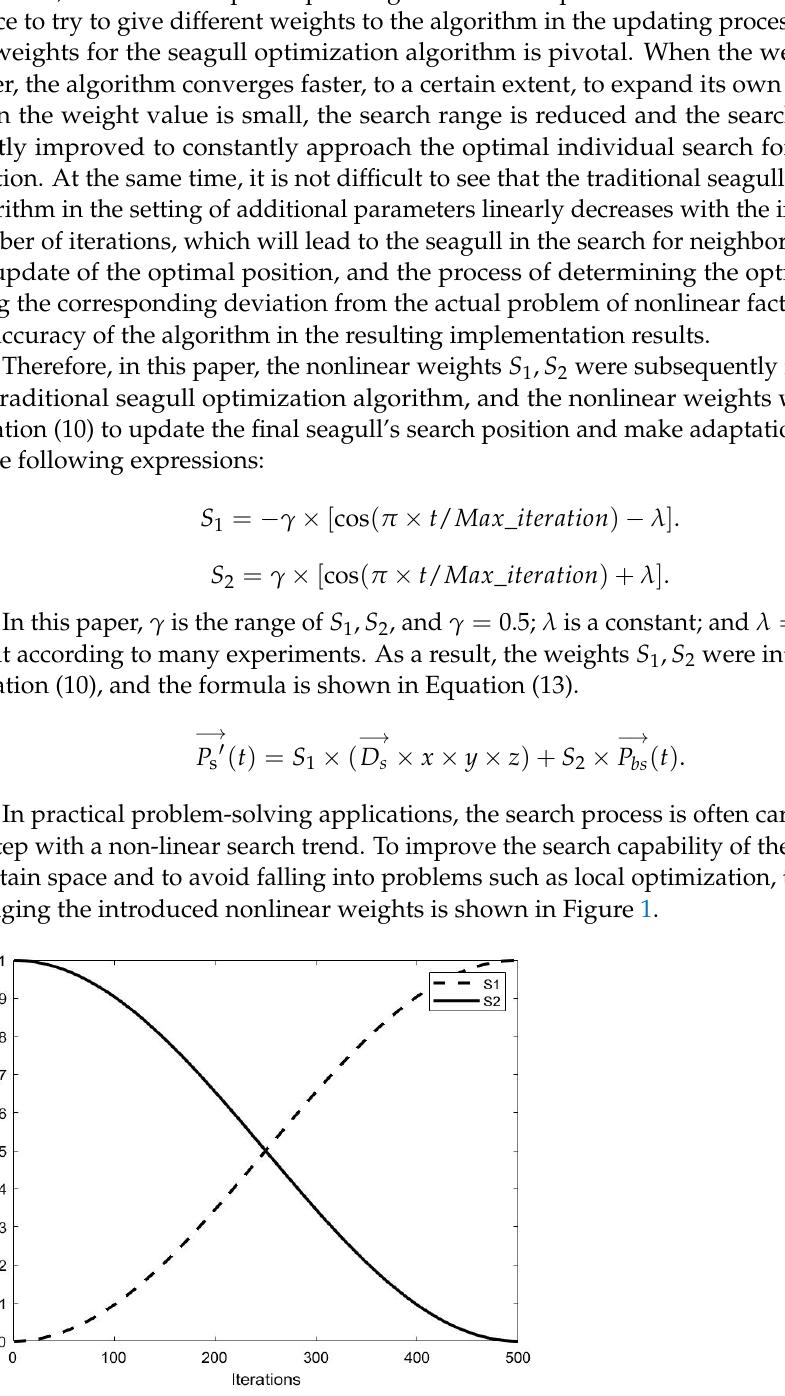
Figure 1. The trend of the nonlinear weights